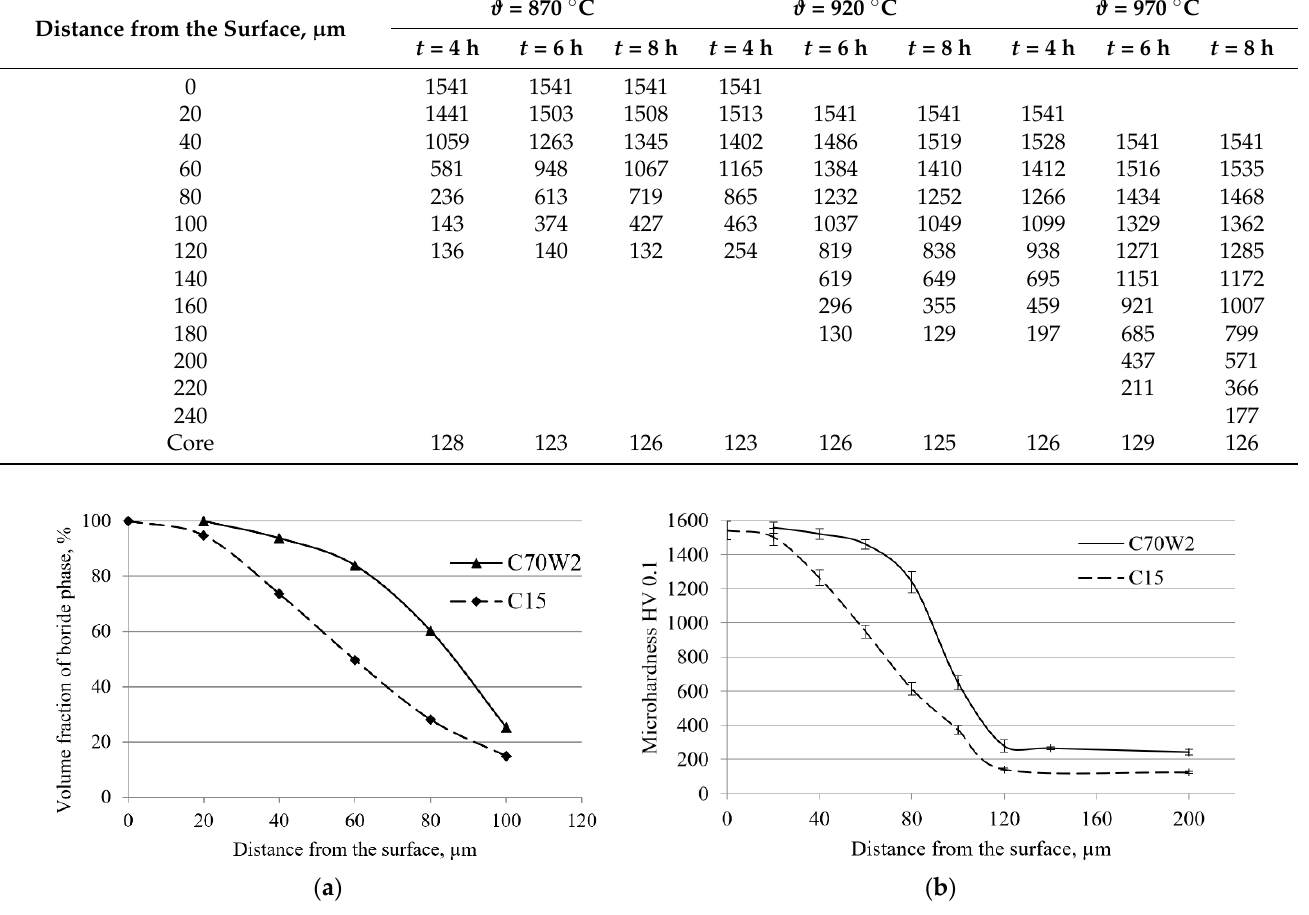
Figure 10. Comparison of the properties of layers of the same average thickness obtained on C70W2 and C15 steels: ( a ) Change in the volume fraction of the boride phase; ( b ) change in cross-sectional hardness.